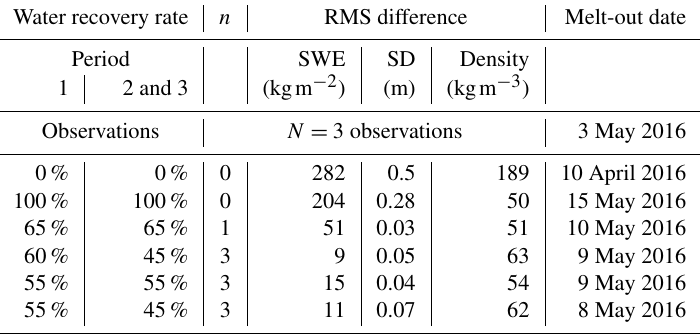
Table 10. Performance of the snowpack model in simulating ski slope snow conditions. n is defined as the number of simulations found within the range of uncertainty for the observation dates. The RMS of the differences between the simulations and the observations are detailed for the 100 and 65% water recovery rate (WRR) simulations, for the three combinations of WRR which provided the best agreement with the observations (Fig. 8) and for the simulation of the groomed snowpack (no production, WRR = 0%). Period 1 extends from 20 November until 5 December 2015. Periods 2 and 3 extend from 5 December 2015 until the melt-out date. Water recovery rate n RMS difference Melt-out date Period SWE SD Density 1 2 and 3 (kgm − 2 ) (m) (kgm − 3 ) Observations N = 3 observations